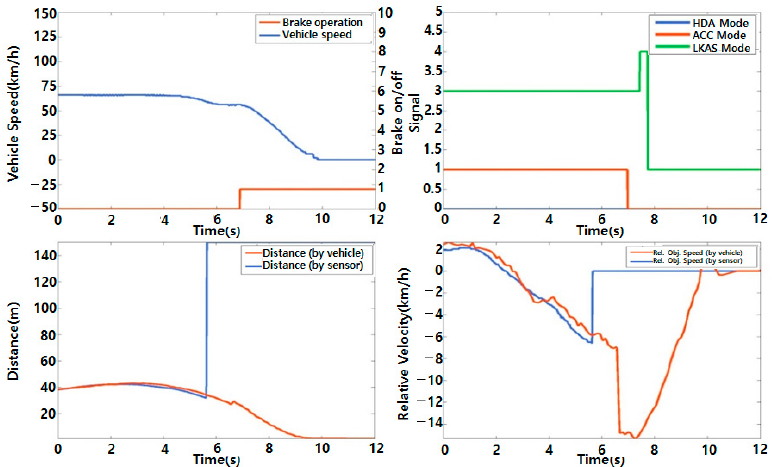
Figure 7. Preliminary data analysis for case 4.